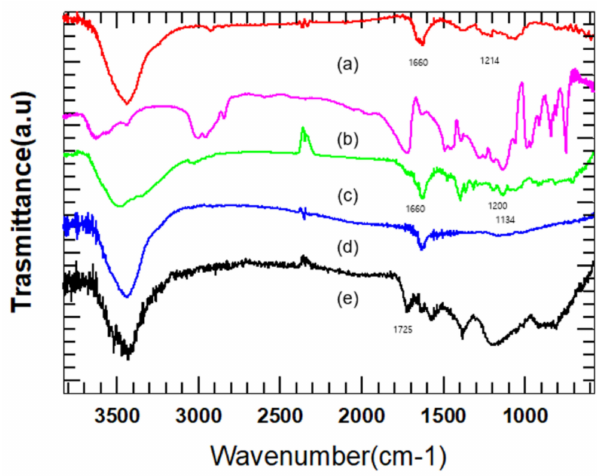
Figure 1. FT-IR spectra of multiwalled carbon nanotubes (MWCNTs): ( a ) MWCNT–NH 2 , ( b ) PMMA, ( c ) PMMA– g –MWCNT, ( d ) raw MWCNT, and ( e )